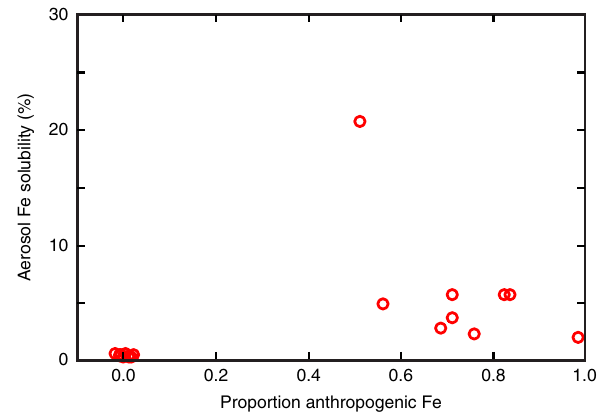
Fig. 3 Water-soluble GA03 aerosol Fe from anthropogenic sources. Proportions of Fe from anthropogenic sources were calculated using a simple two-component isotope mixing equation, and hypothesized δ 56 Fe end members of 0.09 ‰ for dust and − 1.6 ‰ for anthropogenic Fe